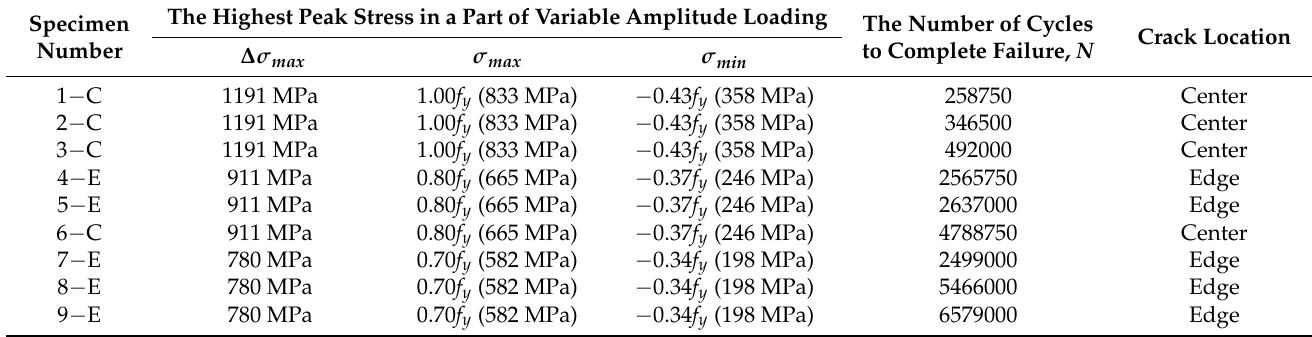
Table 3. Fatigue test results and fracture observation of S690QL in HFMI